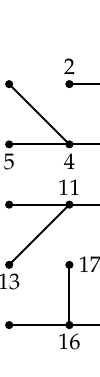
Figure 4. Electrical configuration of the 21-bus test system [30].